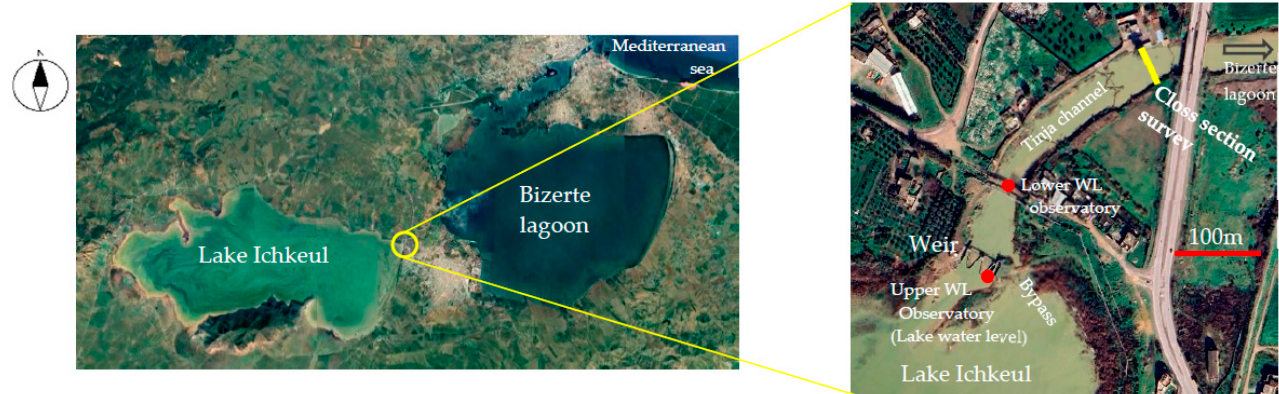
Figure 5. Location of the water level observatories on Tinja channel.